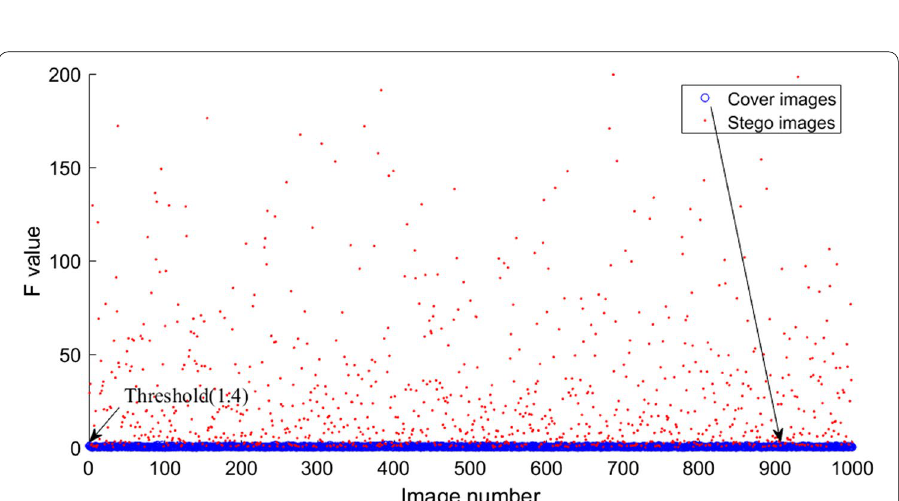
Fig. 9 Distribution of the cover and stego images at an embedding ratio of 10% (type 1 of the PVD interval)